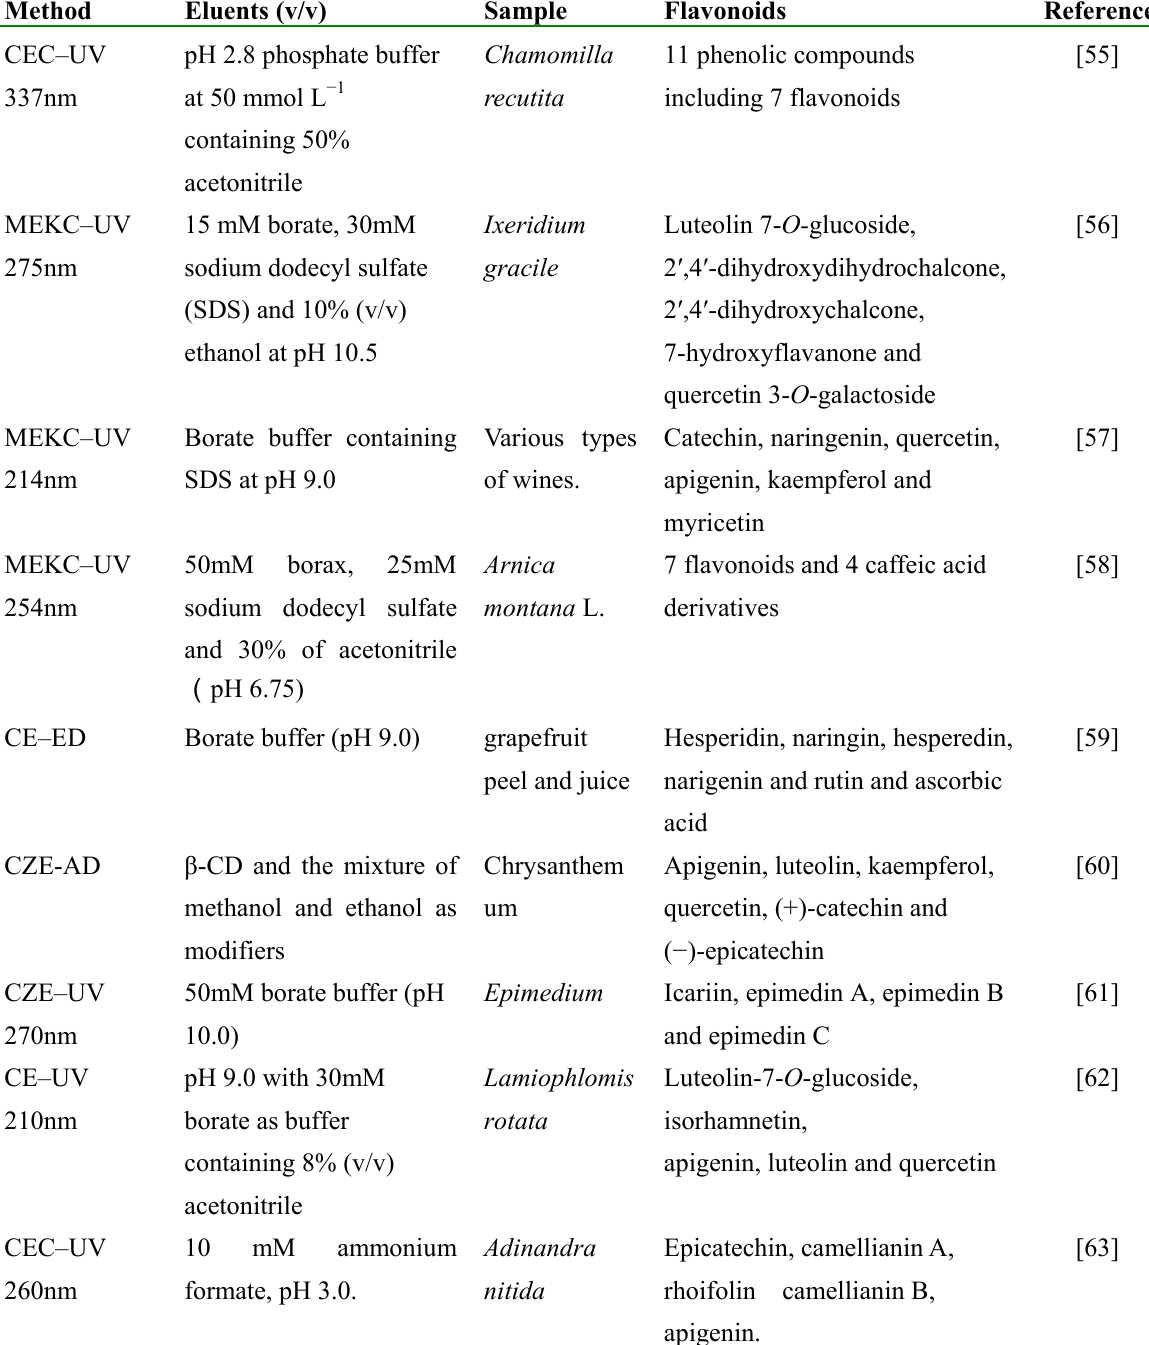
Table 1. Recent publications on LC-MS analysis of flavonoids in